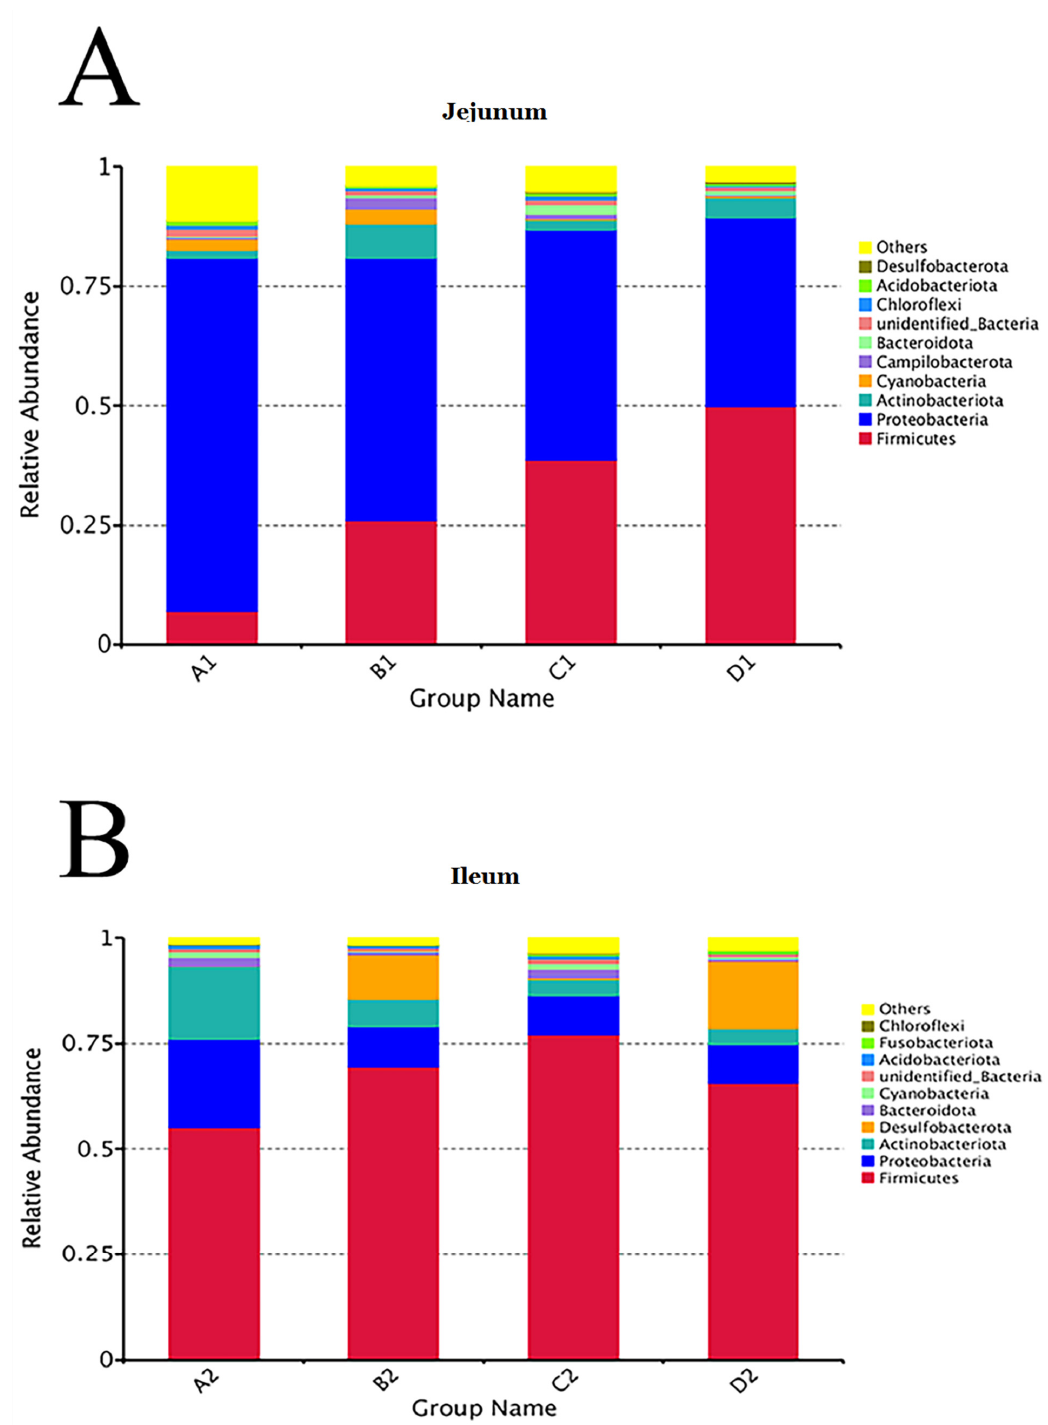
Figure 5. Relative abundance of bacteria in jejunal ( A ) and ileal ( B ) contents at phylum level. Note: Group A (as control) was fed a basal diet, the treatment groups (B, C and D) were fed the basal diet supplemented with 250 mg/kg Clostridium butyricum (viable count 3.0 × 10 6 CFU/g), 250 mg/kg Bacillus subtilis (viable count 2.0 × 10 7 CFU/g), or the combination of 250 mg/kg Clostridium butyricum plus 250 mg/kg Bacillus subtilis , respectively. n =